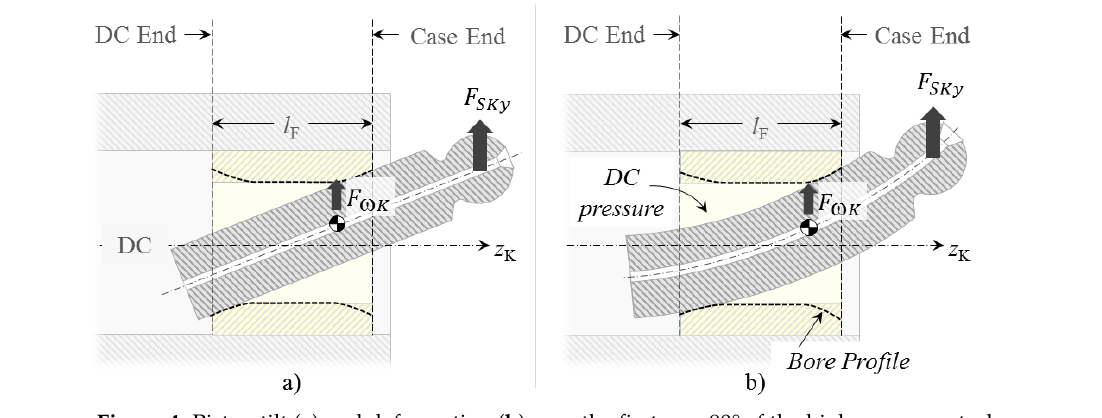
Figure 4. Piston tilt ( a ) and deformation ( b ) over the first ϕ = 90°of the high-pressure